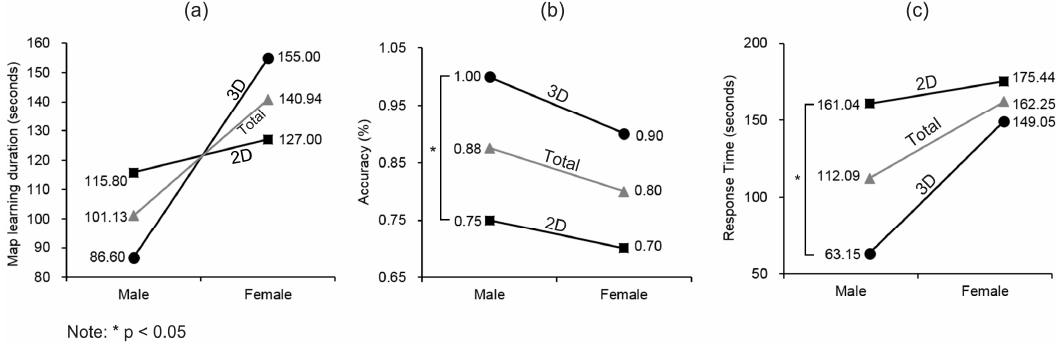
Figure 4. General performance: ( a ) map learning duration; ( b ) accuracy; and ( c ) response time.